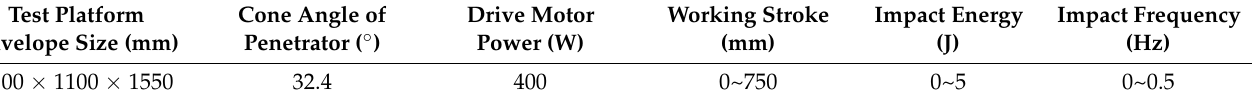
Table 8. Design parameters of the penetration test platform.